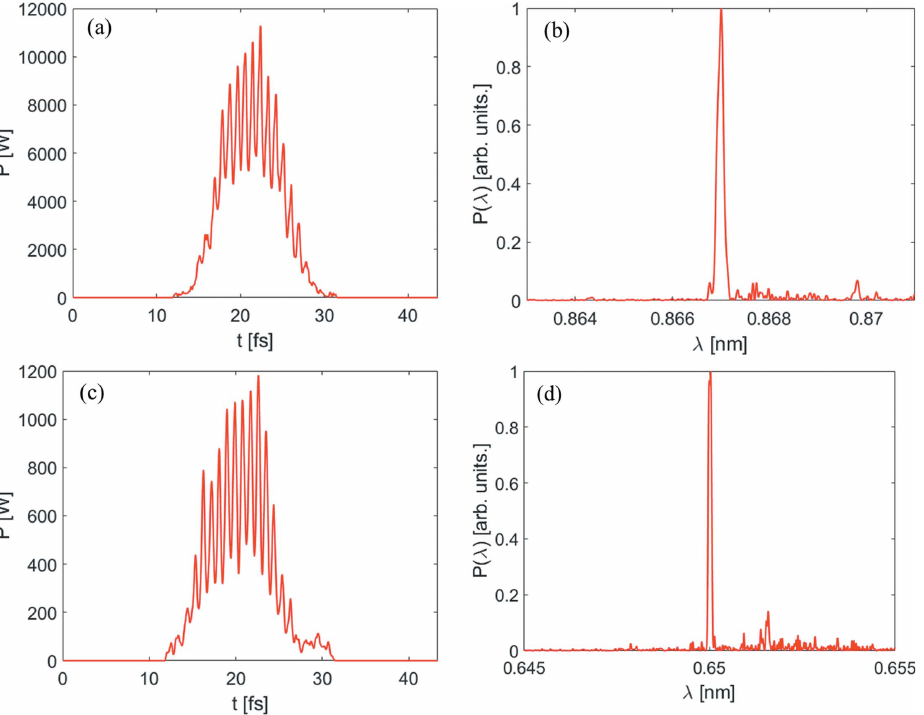
Figure 7 Performances of the proposed technique at the 15th and 20th harmonics of the seed. Panels ( a ) and ( c ) are the output radiation pulses at the 15th and 20th harmonics at the exit of the radiator. Panels ( b ) and ( d ) represent the spectra at the 15th and 20th harmonics at the exit of the radiator.